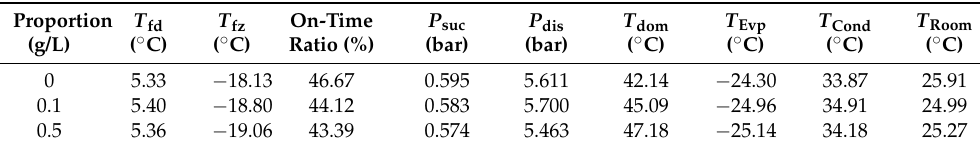
Table 2. Energy consumption results [42].